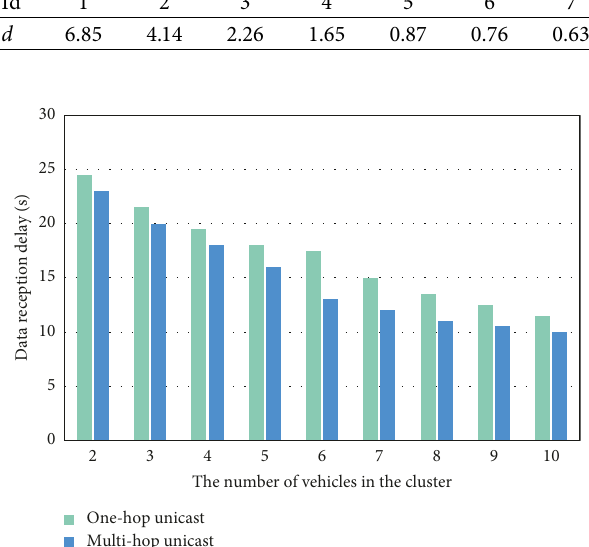
Figure 8: Relationship between data reception rate and the number of vehicles in a cluster based on multihop unicast and one-hop unicast algorithms.